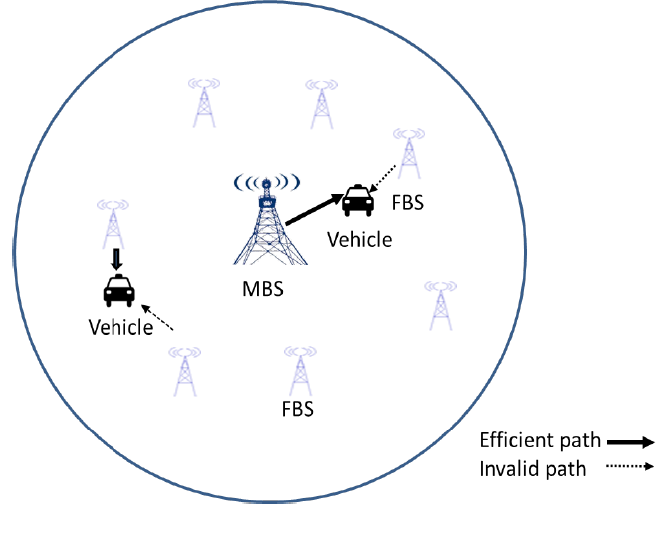
Figure 1. Macro–femtocell